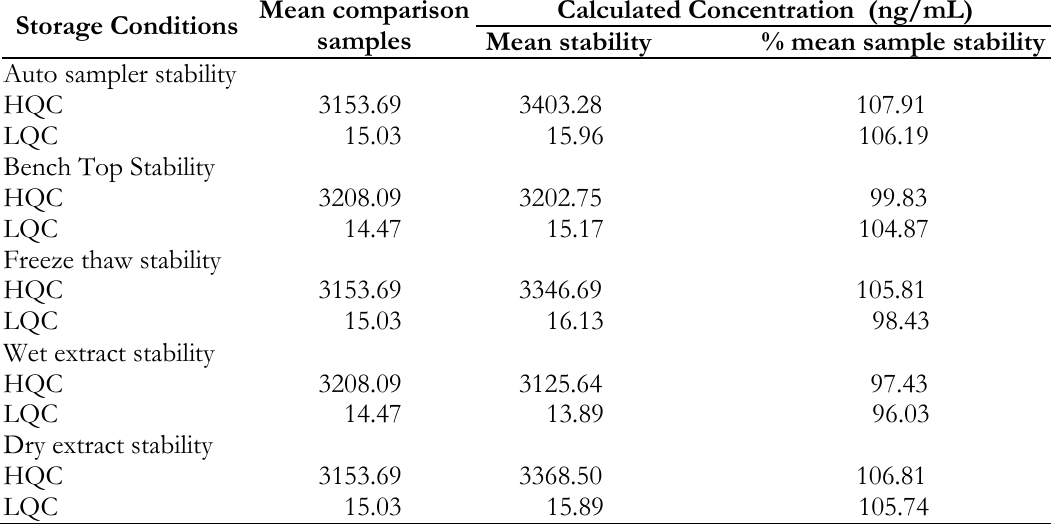
Table IV. Stability Data of omeprazole in Human plasma under various storage conditions (n=6)